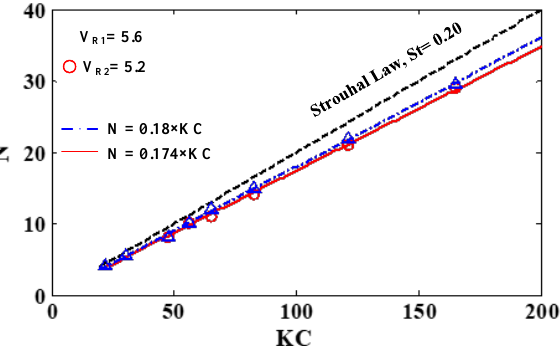
Figure 20. The summarized relationship between vortex-shedding pairs and KC numbers under di ff erent dominant modes.